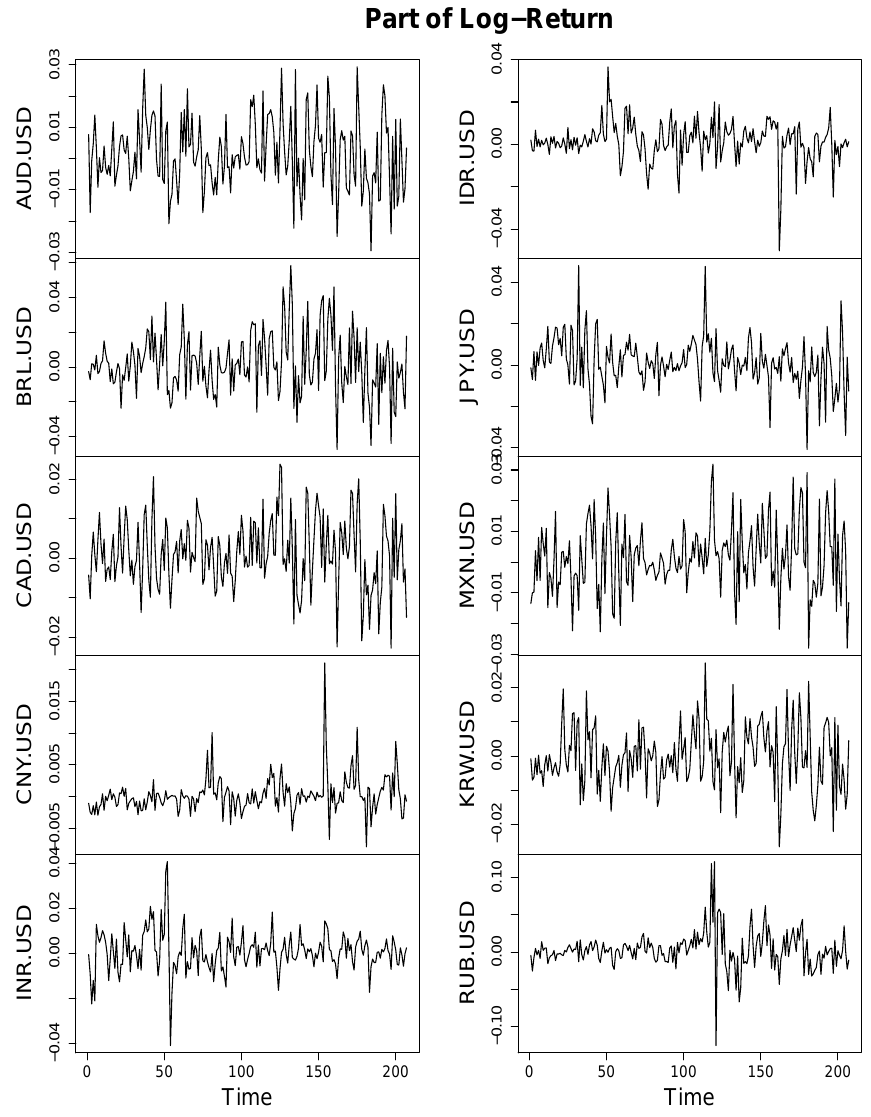
Figure 8. Log return of exchange rates for some of the G20